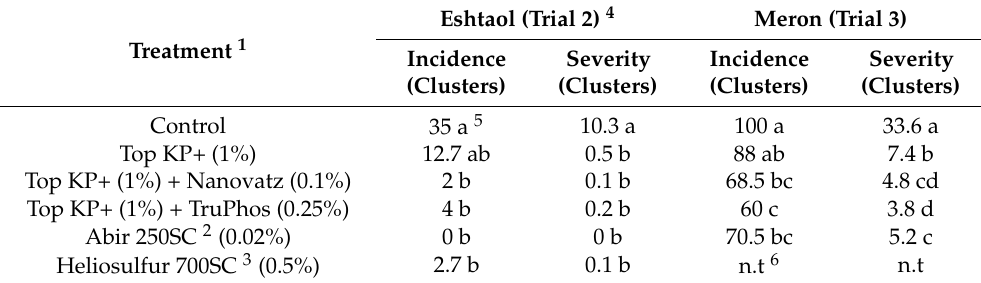
Table 2. Efficacy of nutrients and fungicides in controlling powdery mildew on the clusters of Vitis vinifera cv. Chardonnay at Eshtaol vineyard (trial 2) and at Meron vineyard (trial 3),